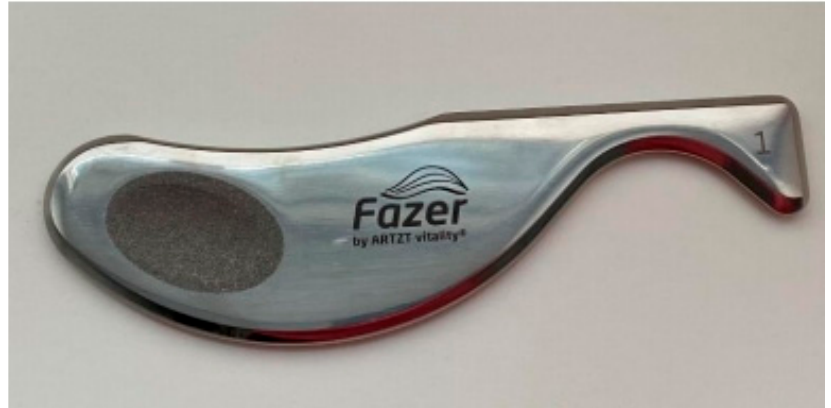
Figure 3. Instrument-assisted soft tissue mobilization tool Fazer 1.